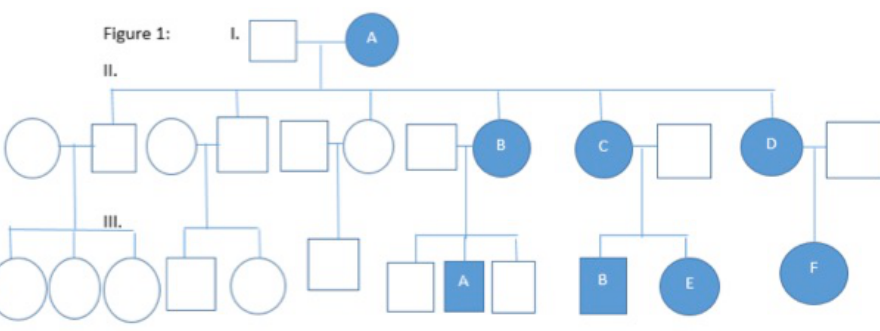
Figure 1. Pedigree of the affected family. Blue color indicates those that have any symptoms pertaining to TMD, whether they be mild, moderate, or severe. Letters are used as identifiers when discussing the